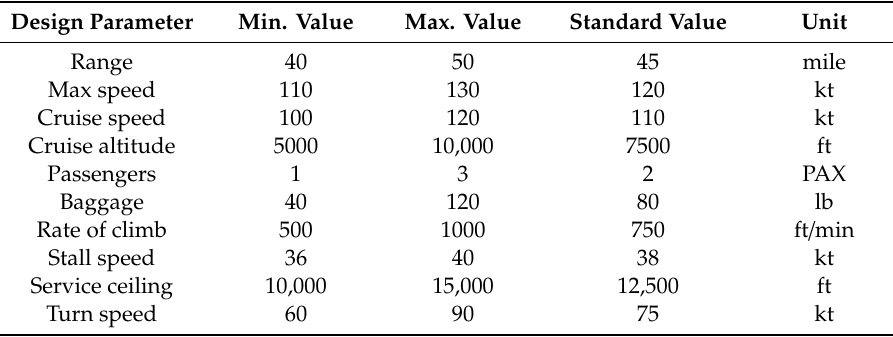
Table 14. Design space of design